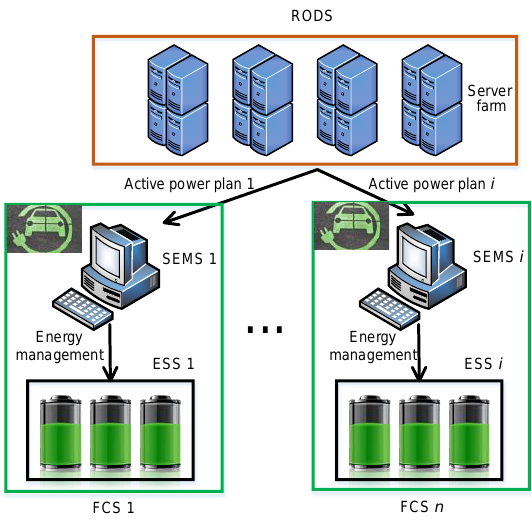
Figure 1. The nodal voltage regulation